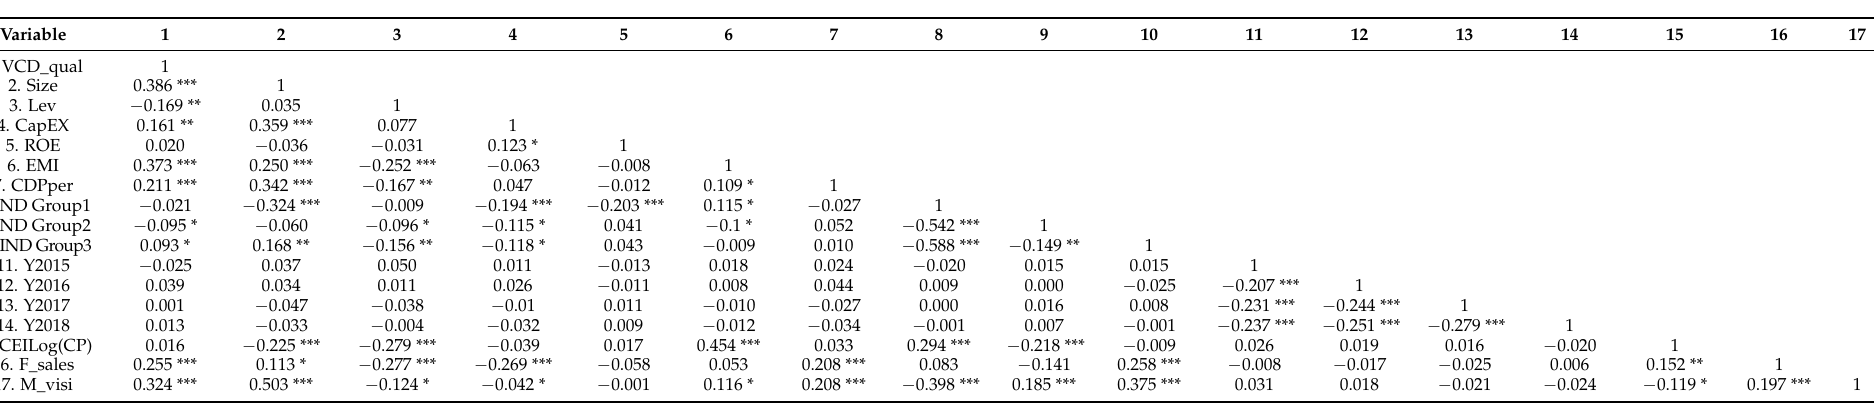
Table 5. Correlation